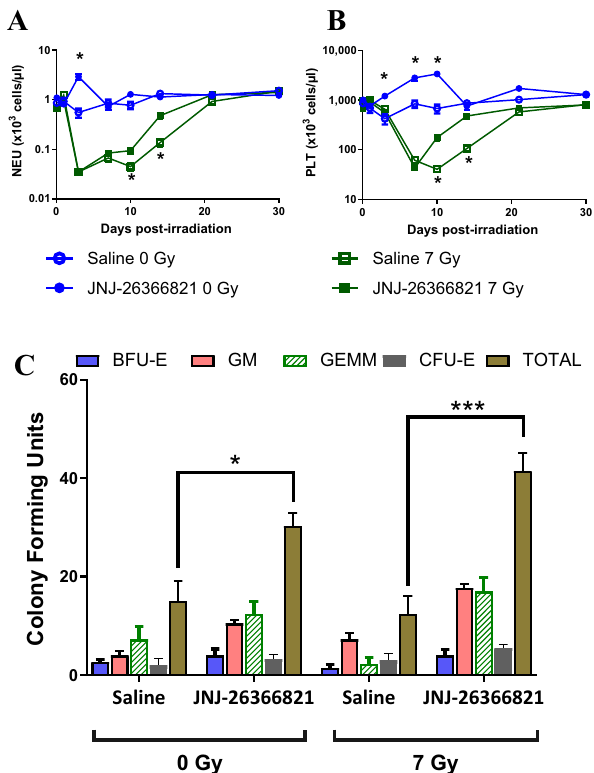
Figure 3. Recovery of peripheral blood cells (neutrophils (NEU) and platelets (PLT)) and bone marrow colony forming units. ( A ) & ( B ) Blood cell counts for days 0 to 30: Saline or JNJ-26366821 at 1 mg/kg was administered 24 h post-irradiation. Day 0 represents 2 h post-irradiation. Non-irradiated mice treated with saline ( ○ ) and JNJ-26366821 ( ● ) and irradiated (7 Gy) mice treated with saline ( □ ) and JNJ-26366821 ( ■ ). Data represented are mean ± standard error of the mean (SEM) for n = 10 mice. Significant difference ( p < 0.001–0.0125) between TPOm treated and saline treated irradiated groups by ANOVA is indicated with an asterisk (*). Some data points in the figure do not have error bars that are visible because they are smaller than symbols. ( C ) Bone Marrow colony forming units for animals administered Saline or JNJ-26366821 (1 mg/kg) both 24 h after irradiation (7 Gy) and in non-irradiated animals (0 Gy) Significant difference * p = 0.04, *** p = 0.0010. Figures were plotted using GraphPad Prism 9 software V9.0.2; www. graph pad.